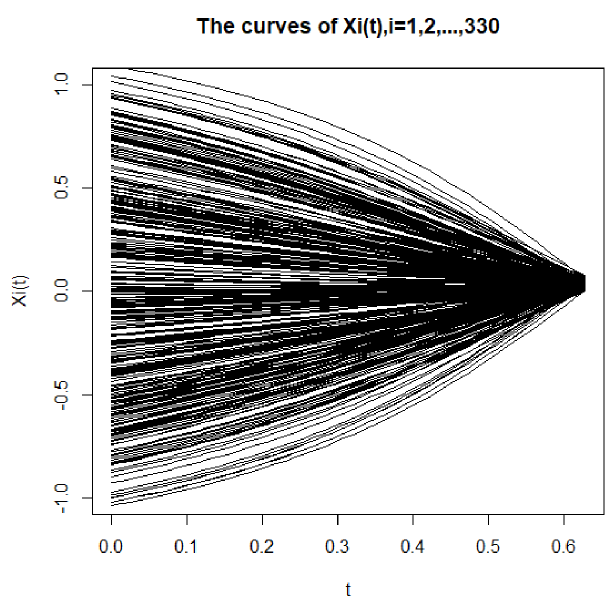
Figure 1. Curve-sample with sample size of n =